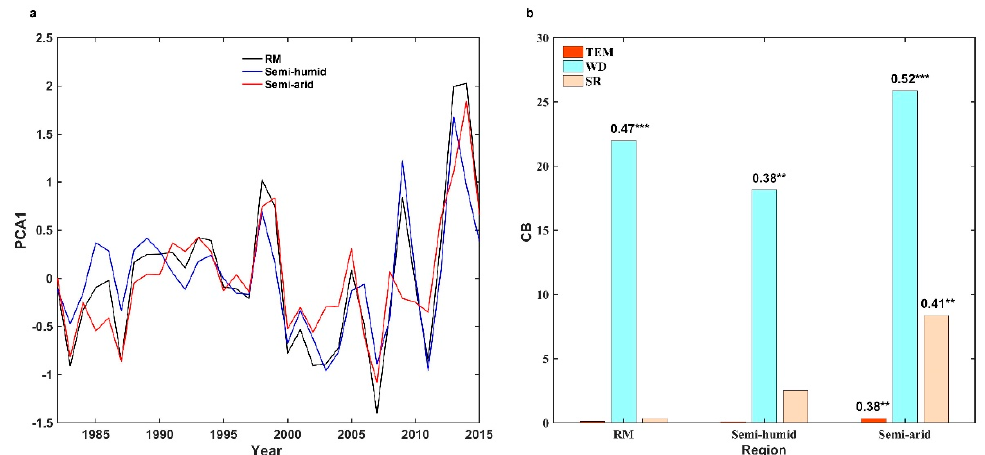
Figure 7. The first principal component (PCA1) of TRI chronologies in different sub-regions (the whole study region, RM and semi-humid and semi-arid) ( a ) and the relative contributions of growing season TEM, WD and SR to variations in TRI in different regions ( b ). The values on the bars in (b) are the corresponding partial correlation coefficients, and *, ** and *** indicate statistical significance at p < 0.1, p < 0.05 and p < 0.01 levels, respectively, with Student’s t -test.